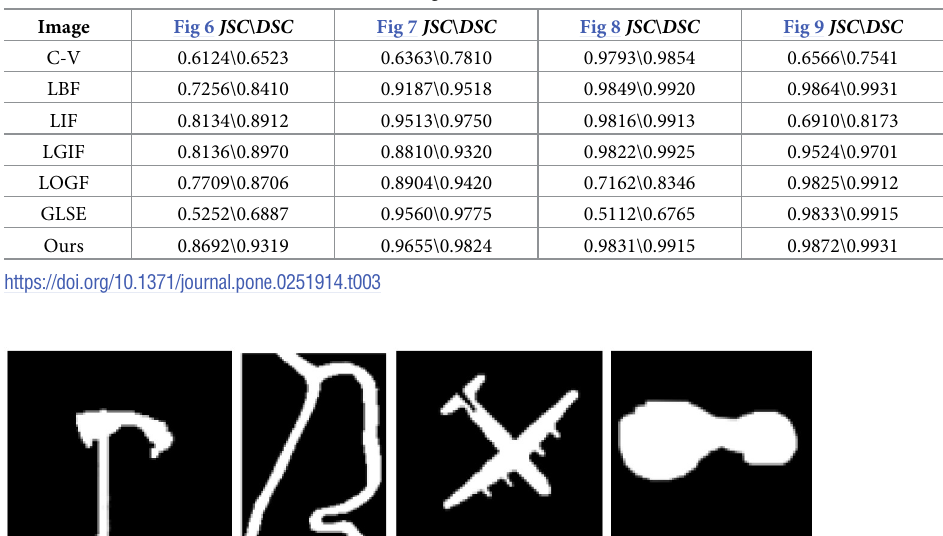
Table 3. The JSC and DSC of different models for Figs 6–9.